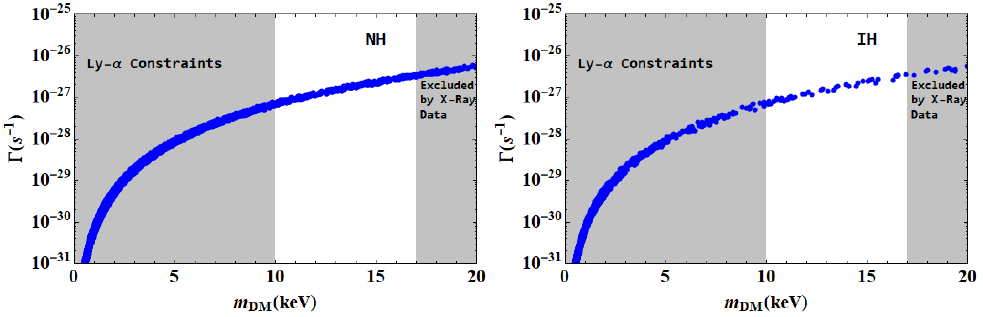
Figure 1 . DM-active mixing as a function of the mass of the DM for both normal hierarchy as well as inverted hierarchy.